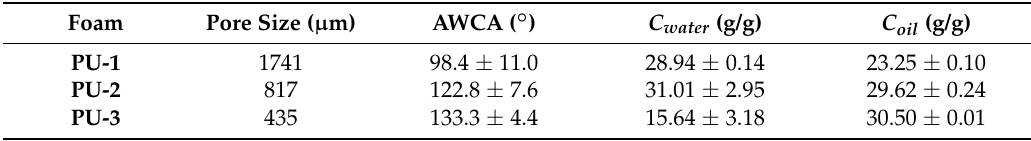
Table 1. Polyurethane (PU) pristine foams’ properties: pore size, apparent water contact angle (AWCA), and water and oil absorption